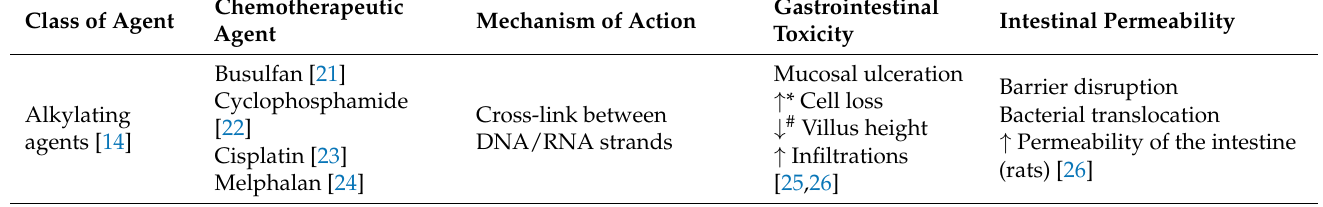
Table 1. Most common anti-cancer agents used during chemotherapy and impact on the gastrointestinal tract. Class of